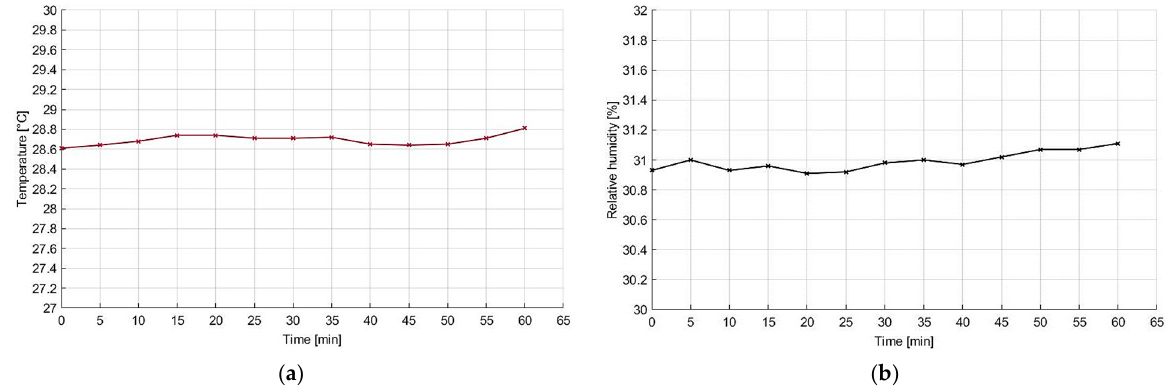
Figure 9. Environmental conditions ( a ) temperature ( b ) relative